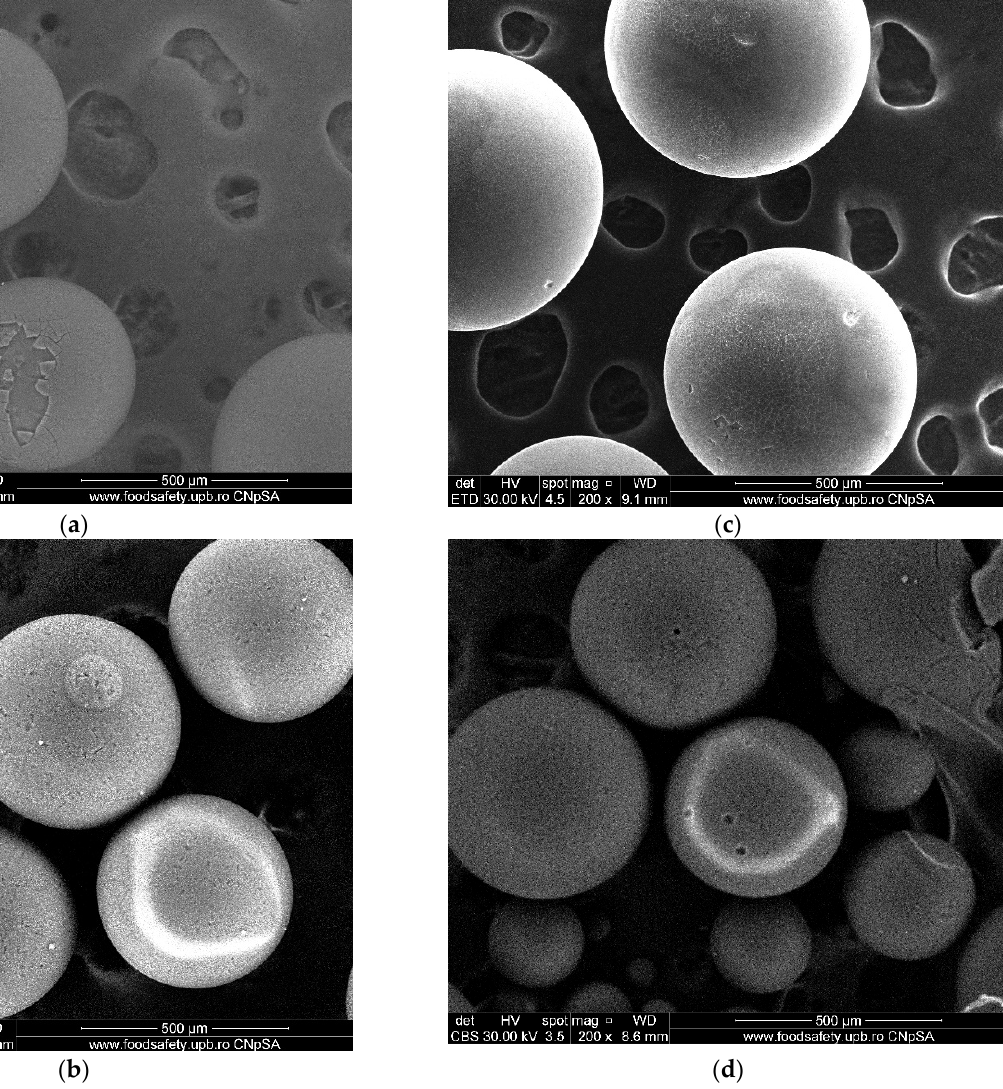
Figure 10. SEM Images of ( a ) IRA 402-DR23, ( b ) IRA 402-DR23-M 2+ , ( c ) XAD7HP-DR23 and ( d ) XAD7HP-DR23-M 2+ .